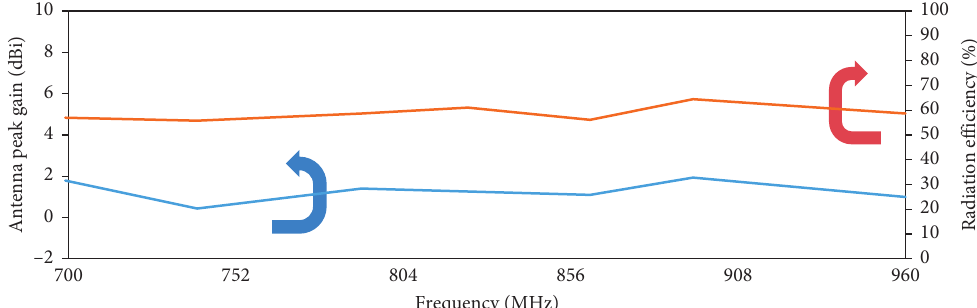
Figure 9: Gain and radiation efficiency measured for the developed antenna at 700–960MHz.